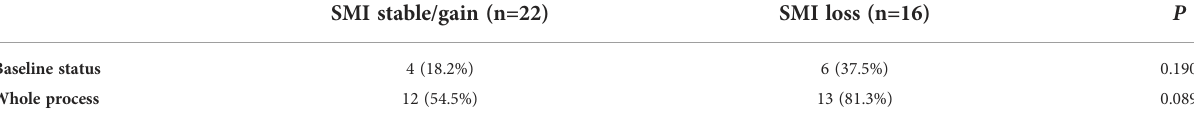
TABLE 4 Relevance between SMI change and toxicity